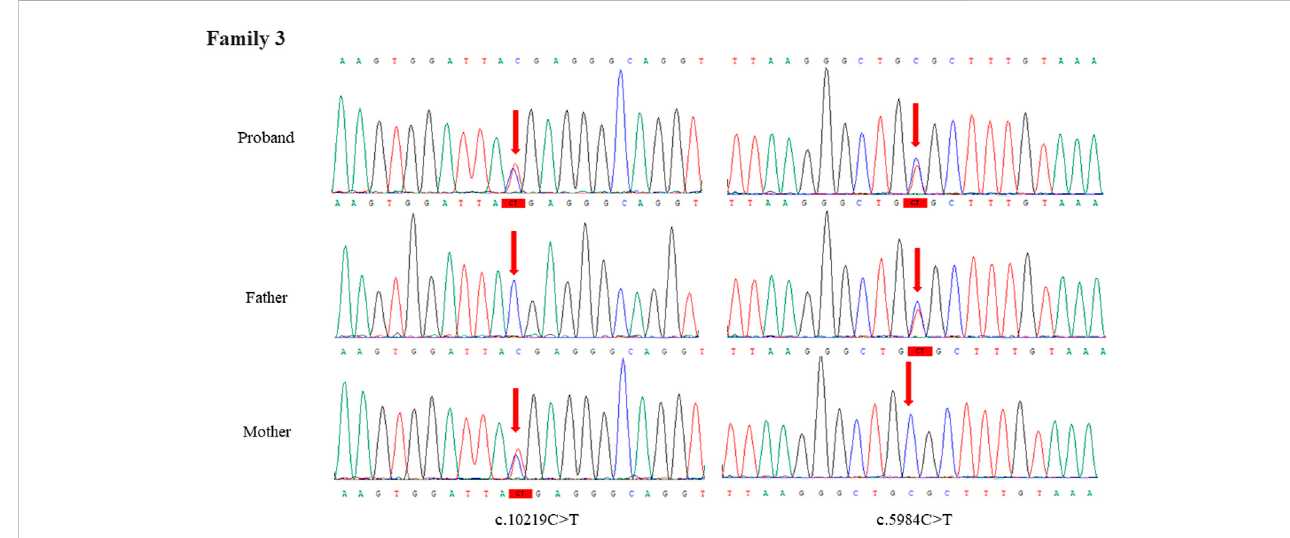
FIGURE 7 Sanger sequence analysis of the mutations of DYNC2H1 gene in the family 3.